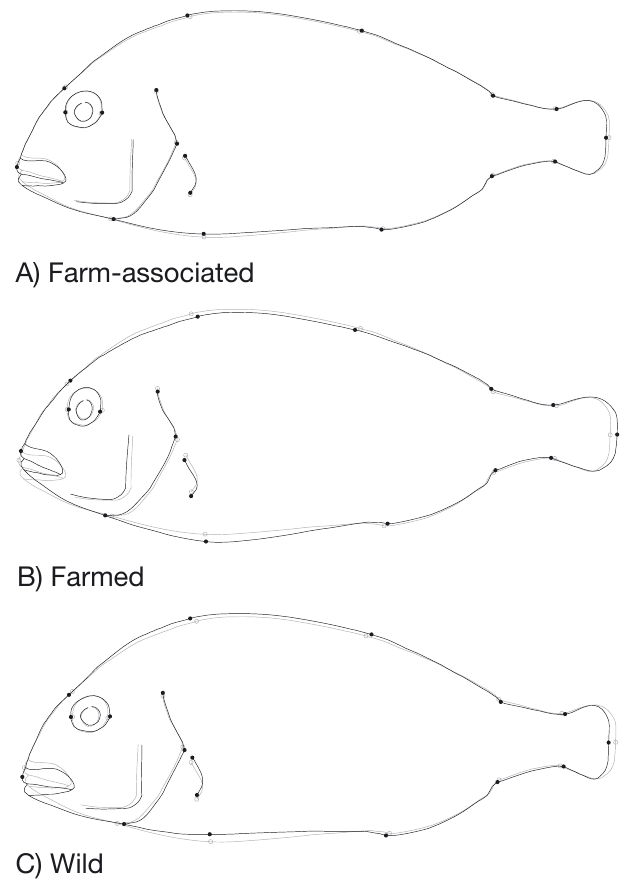
Fig. 2. Warped outline drawings of mean shapes for gilthead seabream from different origins. The light grey outline rep- resents the transformation from the overall mean shape, while the black outline represents the mean shape of each origin. Analysis of Procrustes distances showed that all 3 pairwise origin comparisons were significantly different (p < 0.0001). The shape differences were exaggerated 2-fold for better visualisation. The landmarks are defined in Fig. S1 in